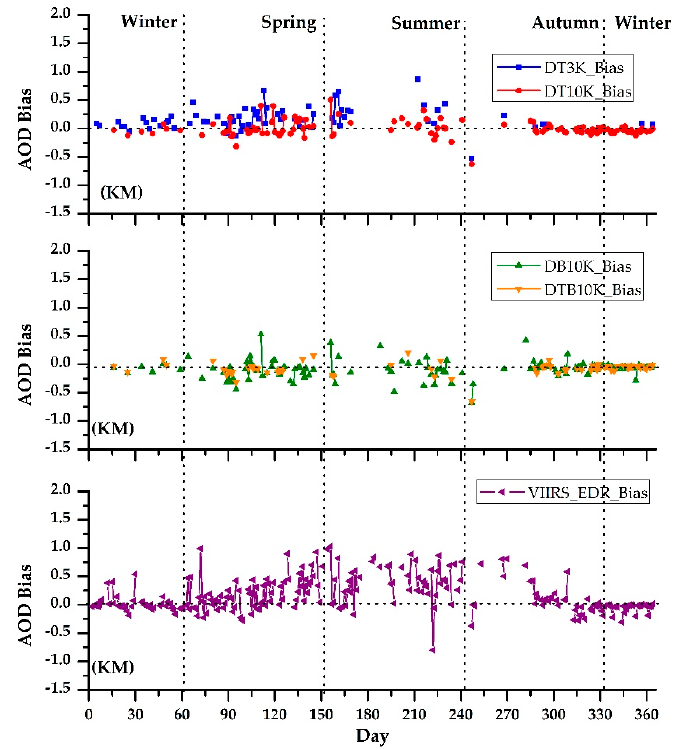
Figure 12. As in Figure 9, but for KM during 2 May 2012–31 December 2013.